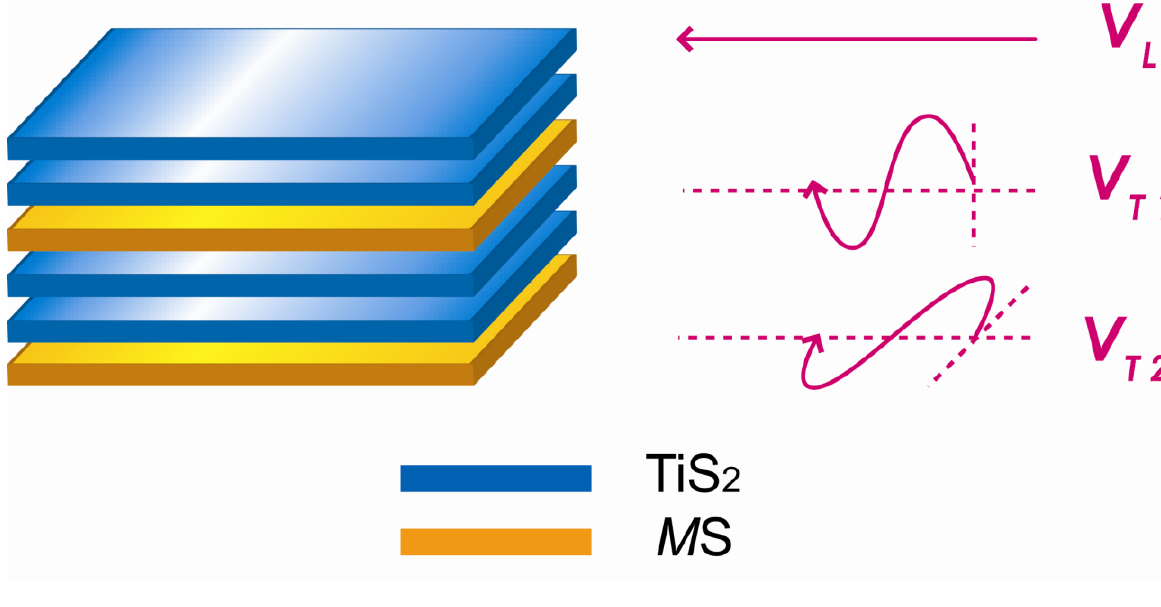
Table 1. Densities, longitudinal and transverse sound velocities, and shear moduli of TiS 2